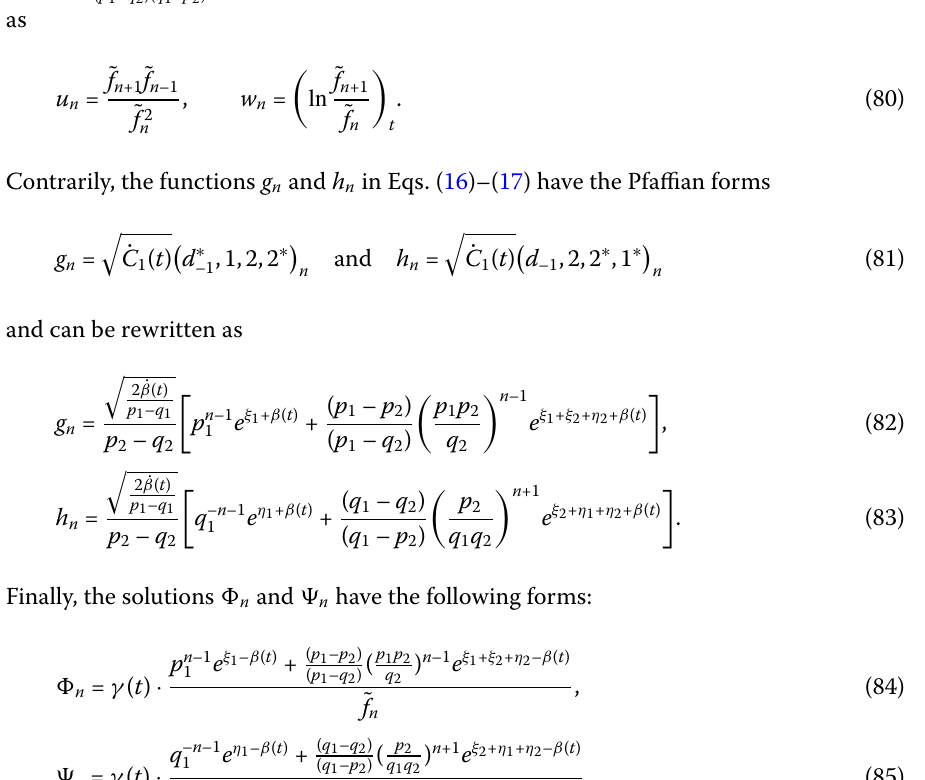
and A = ( p 1 – p 2 )( q 1 – q 2 ) . Subsequently, we obtain the expressions for the solutions u n and w ( p 1 – q 2 )( q 1 – p 2 )